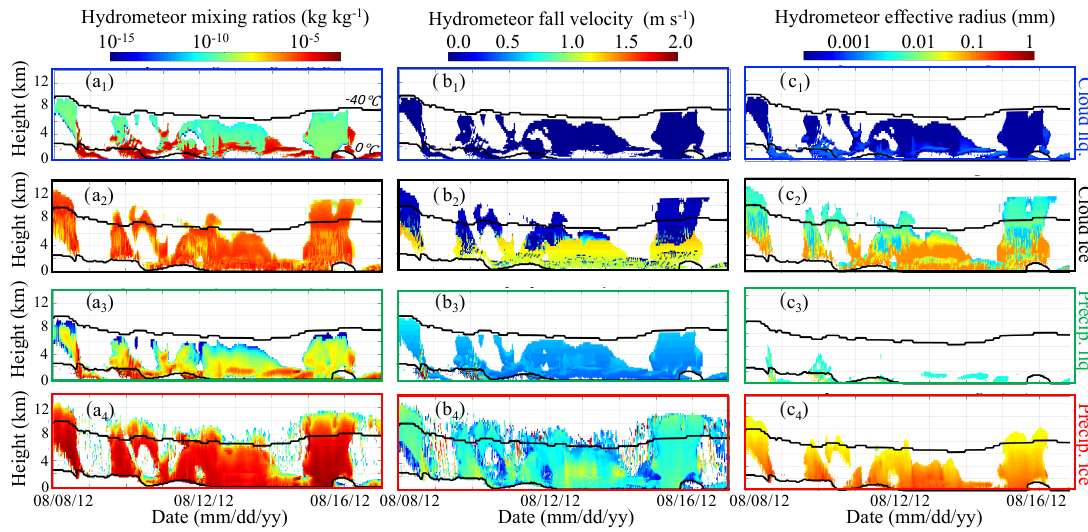
Figure 2. Sample time series of ModelE outputs: (a 1–4 ) mixing ratios, (b 1–4 ) mass-weighted fall speed (positive values indicate downward motion) and (c 1–4 ) effective radii for cloud droplets (1; blue boxes), cloud ice particles (2; black boxes), precipitating liquid drops (3; green boxes), and precipitating ice particles (4; red boxes). Also indicated are the locations of the 0 and − 40 ◦ C isotherms (horizontal black